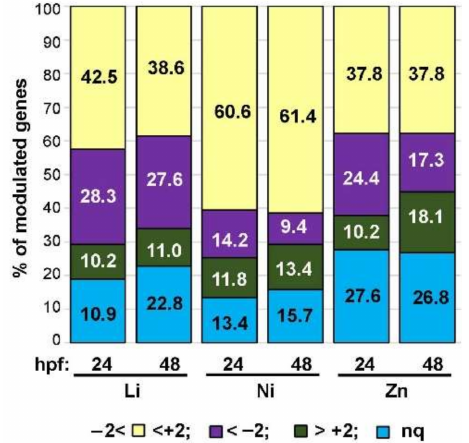
Figure 3. Percentages of genes modulated by metal treatments. Percentages of genes modulated by Li (30 mM LiCl), Ni (0.5 mM NiCl 2 ) and Zn (0.1 mM ZnSO 4 ) treatments at 24 and 48 hpf (hours post-fertilization). The fill colors indicate the upregulated genes in green (>+2), downregulated genes in violet (< − 2), not responsive in light yellow (between − 2 and +2), and not quantifiable (nq) in light blue.